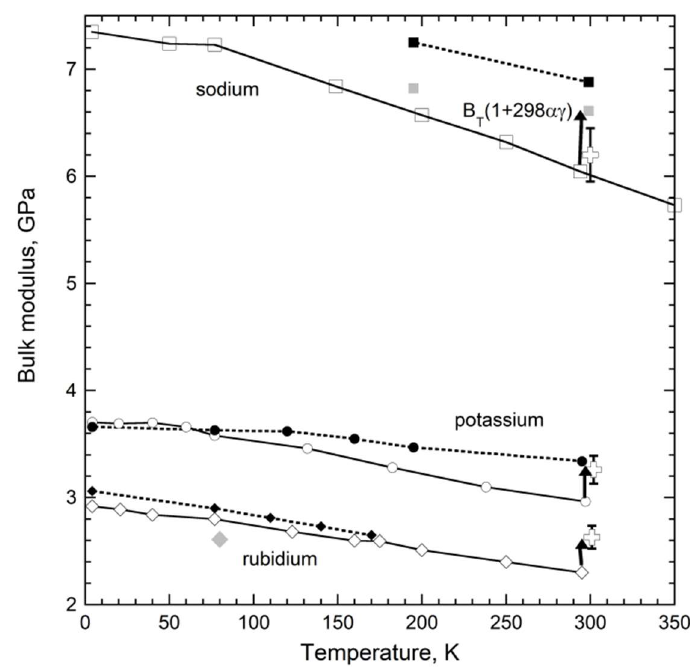
Figure 10. Temperature dependence of bulk moduli for alkali metals. Filled symbols = acoustic data of [61–63]; grey represents previous work cited therein. Open symbols = volumetric (XRD) studies analyzed using simple forms for the EOS [64]. Open cross = length-change data [46], which are closer to acoustic results than to B from XRD. Otherwise, squares show various data on Na; circles for K; and diamonds for Rb. Arrow at 298 K shows the historic Equation (23) applied to XRD data.